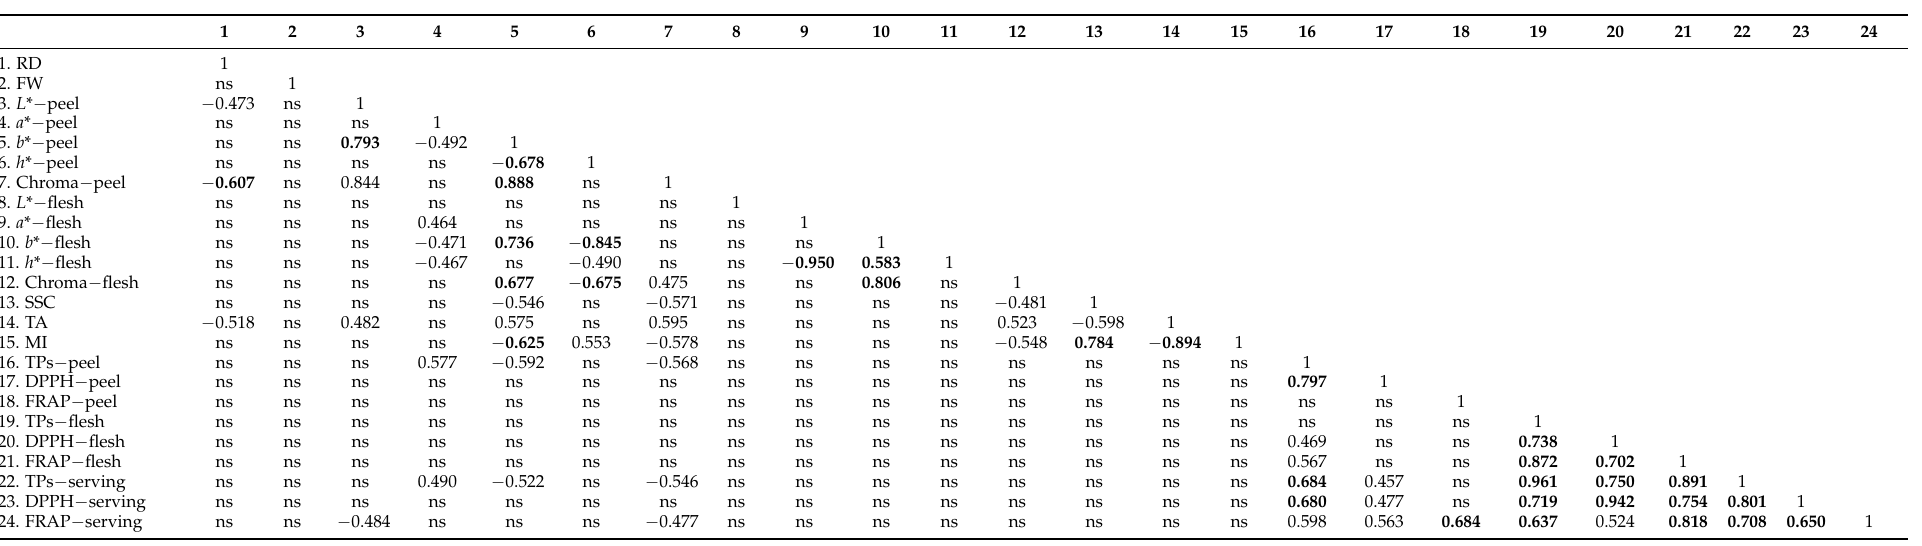
Table 3. Pearson correlation analyses between phenotypic and chemical traits in 19 European plum cvs. RD, ripening date; FW, fruit fresh weight; SSC, soluble solid content; TA, titratable acidity; MI, maturity index; TPs, total phenols; DPPH and FRAP, total antioxidant capacity using the DPPH and FRAP radicals, respectively. ns. non significant; Absolute linear correlations ≥ |0.60| are marked in